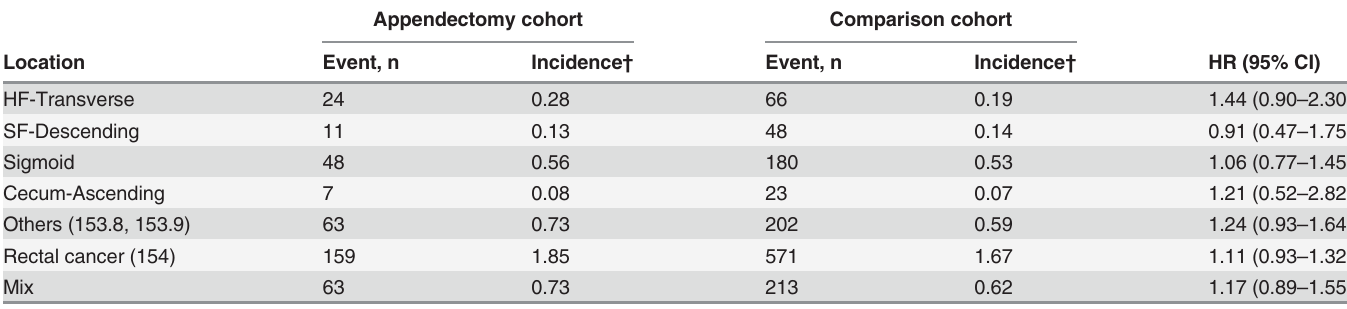
Table 3. Incidence of colorectal cancer by site and hazard ratio of the site-speci fi c appendectomy cohort to the comparison cohort. Appendectomy cohort Comparison